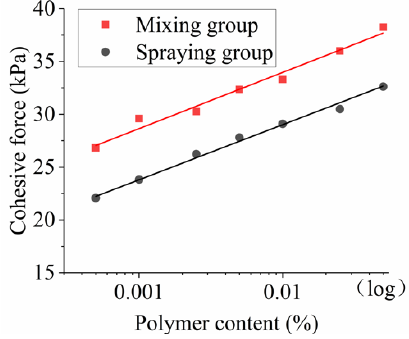
Figure 8. The relationship between the cohesive force and polymer content.